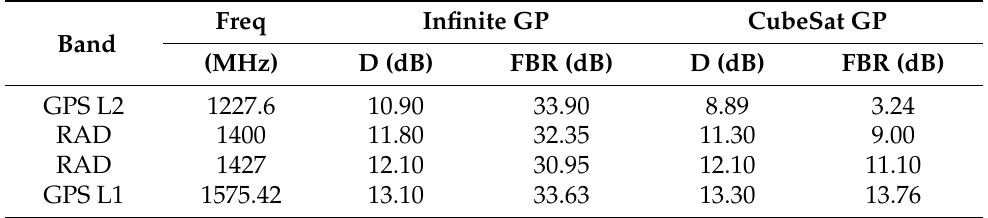
Table 5. Simulation results for Infinite and CubeSat-sized ground planes.